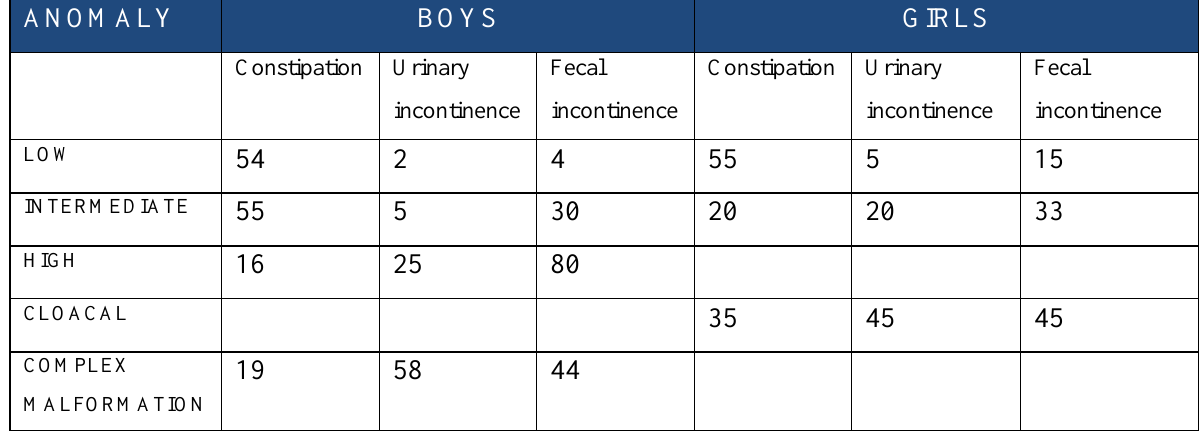
Table 1: Long-term outcome of children with Anorectal